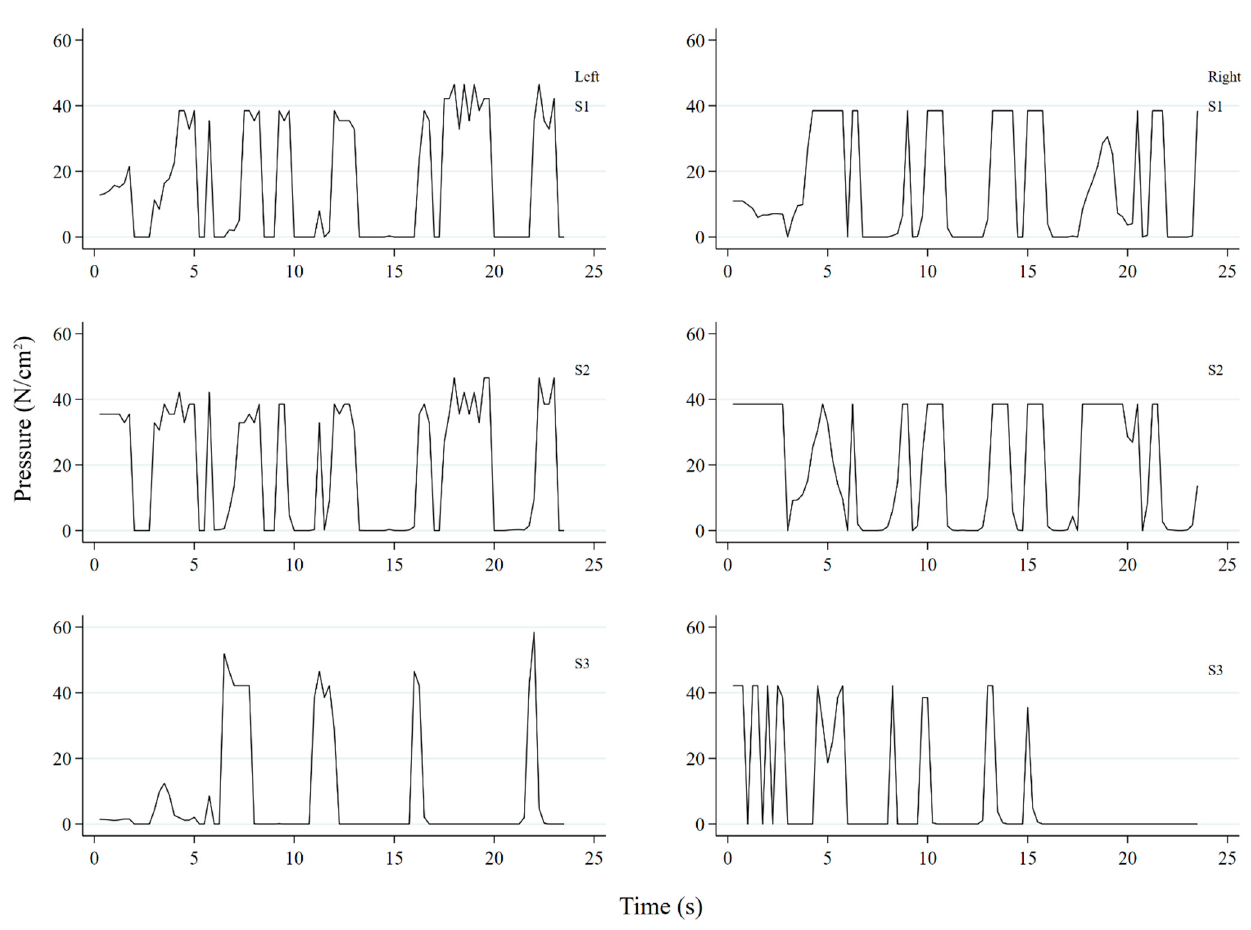
Figure 3. Values obtained from the FSR-based system in a walk trial with the standard insole.